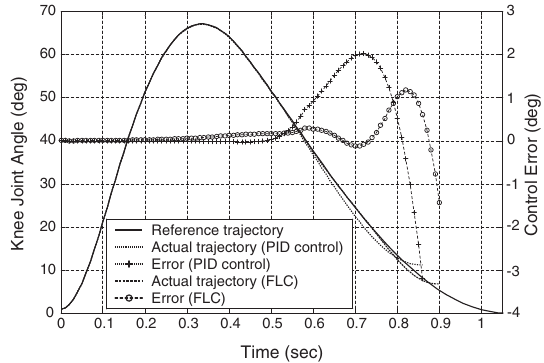
Fig. 9. FES control of SBO with reference trajectory derived from passive oscillation.